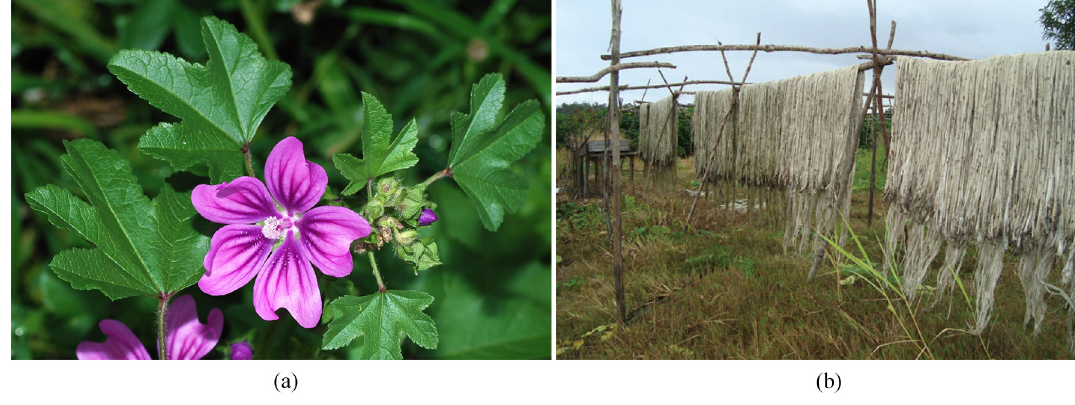
Figure 1. Malva plant (a) and fibers drying after extraction (b).